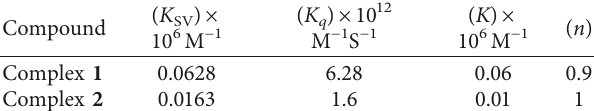
Table 4: K SV , Kq , ( n ), and K values of complexes 1 and 2 .